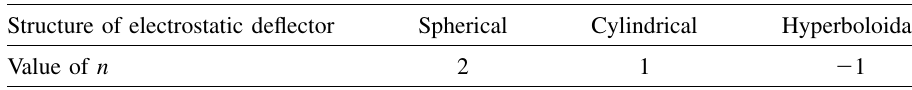
TABLE 1. Field index of electrostatic